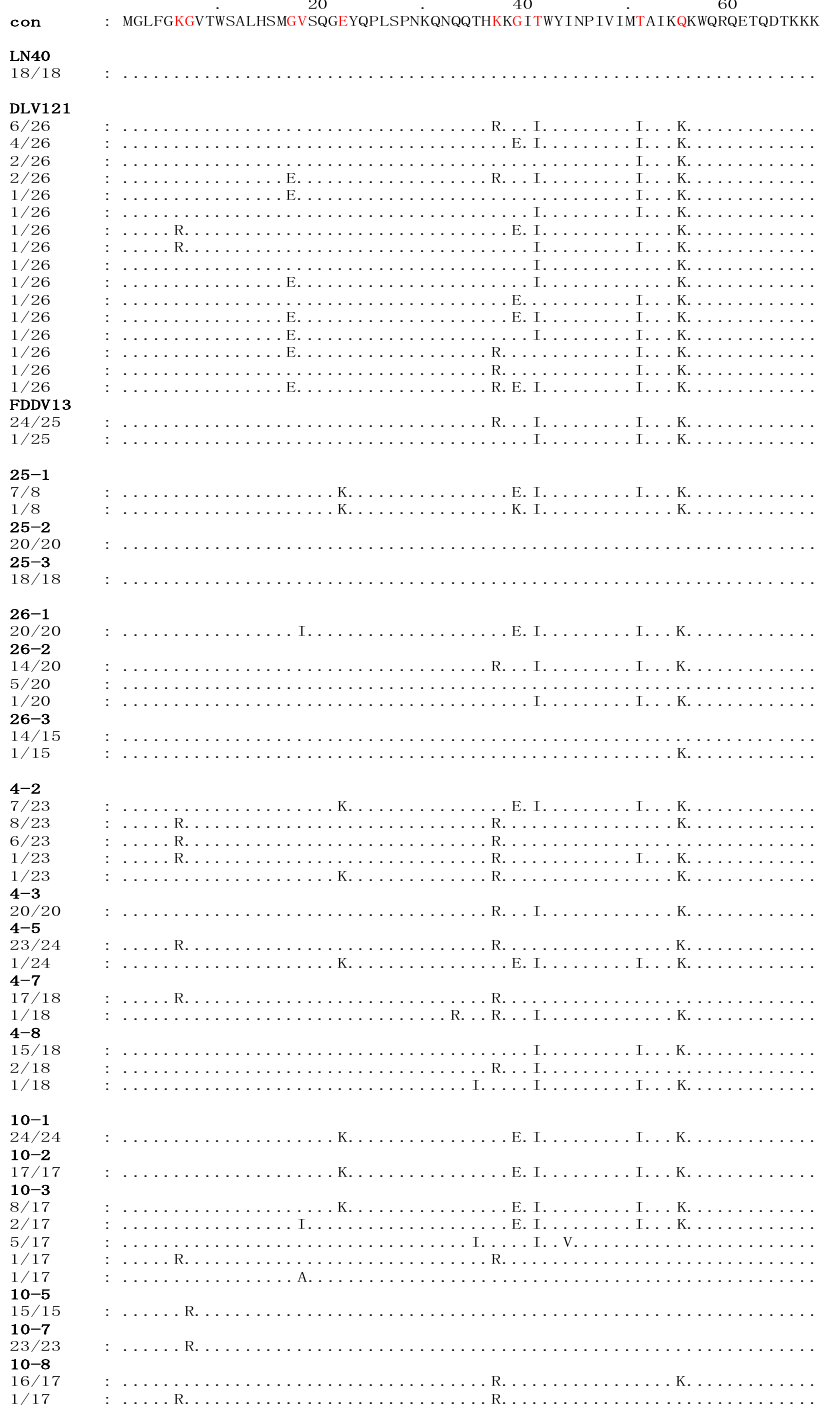
Figure 1. The deduced multiple the deduced sequence alignment of amino acids encoded by the S2 genes of viruses isolated from four EIAV LN40 -infected horses. The sequences of all the viral clones were aligned to the consensus sequence (con) of EIAV LN40 , shown at the top. Only the amino acid residues that are different from the consensus sequence of EIAV LN40 are indicated. The dots indicate residues identical to the consensus sequence. The numbers in the left column in each sequence indicate the number of a specific sequence in the total detected clones of each sample. The red letters denote the stable